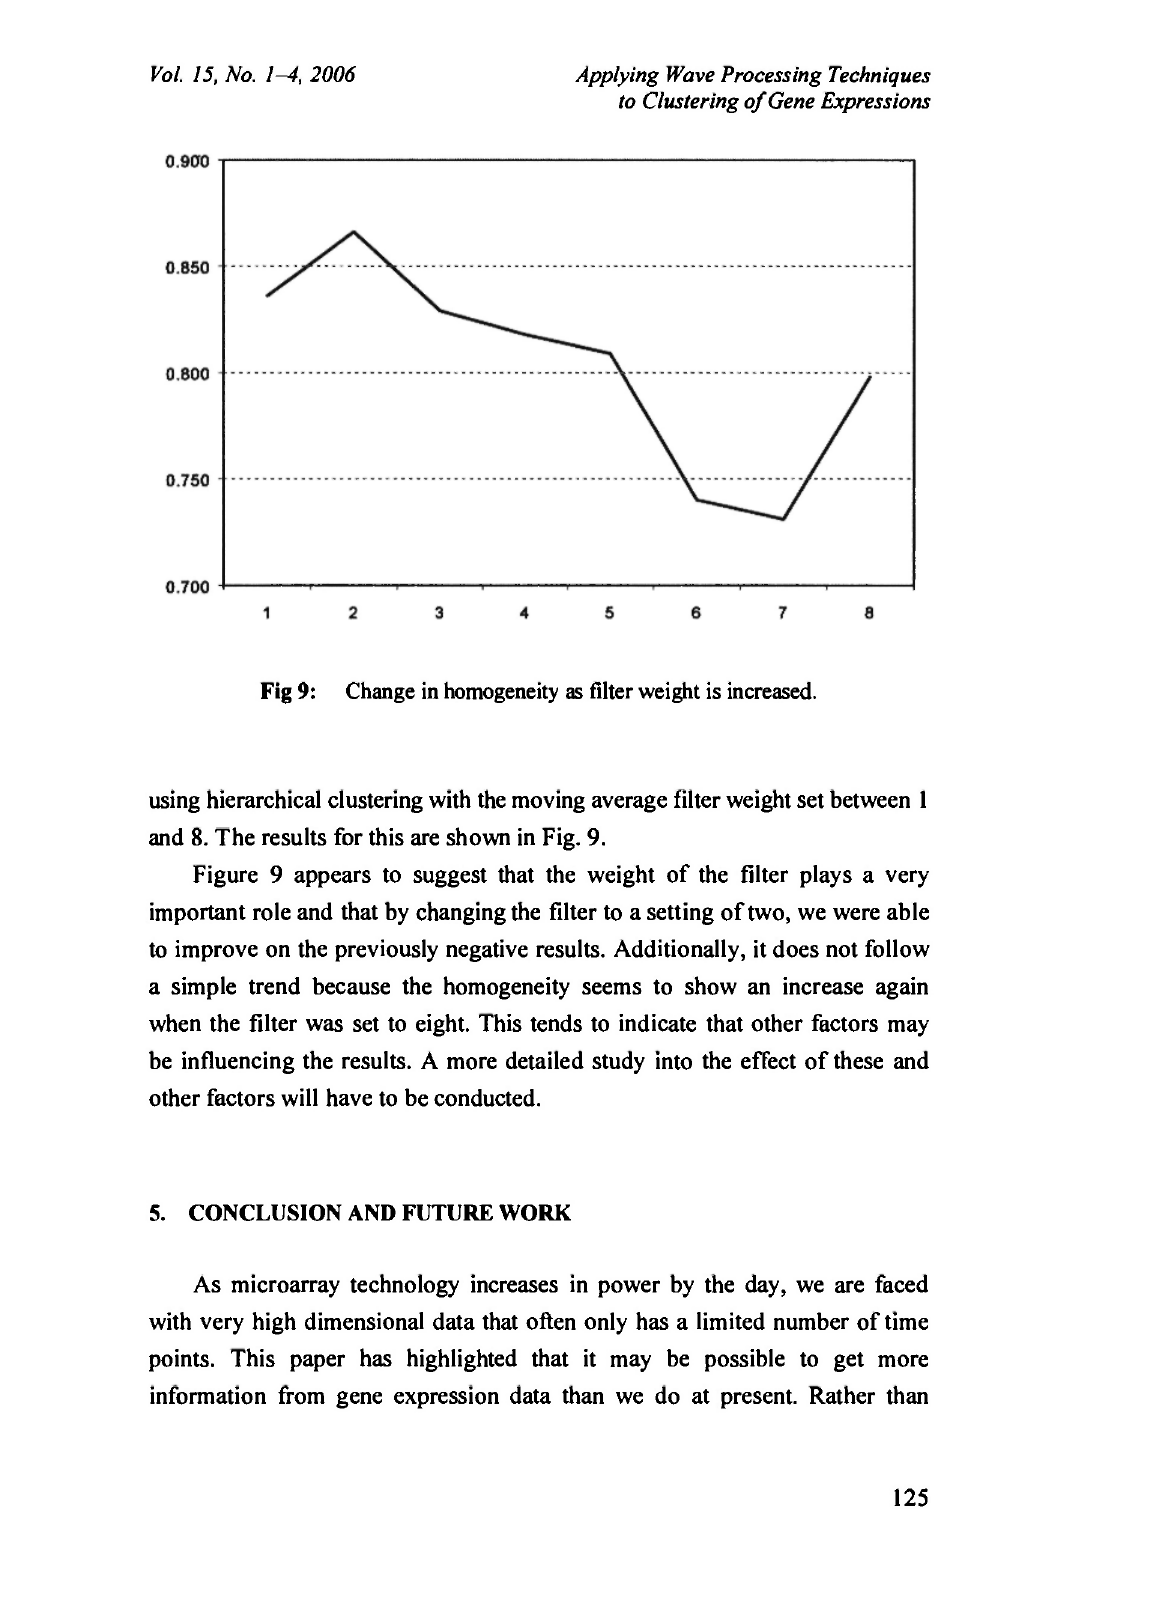
Fig 9: Change in homogeneity as filter weight is